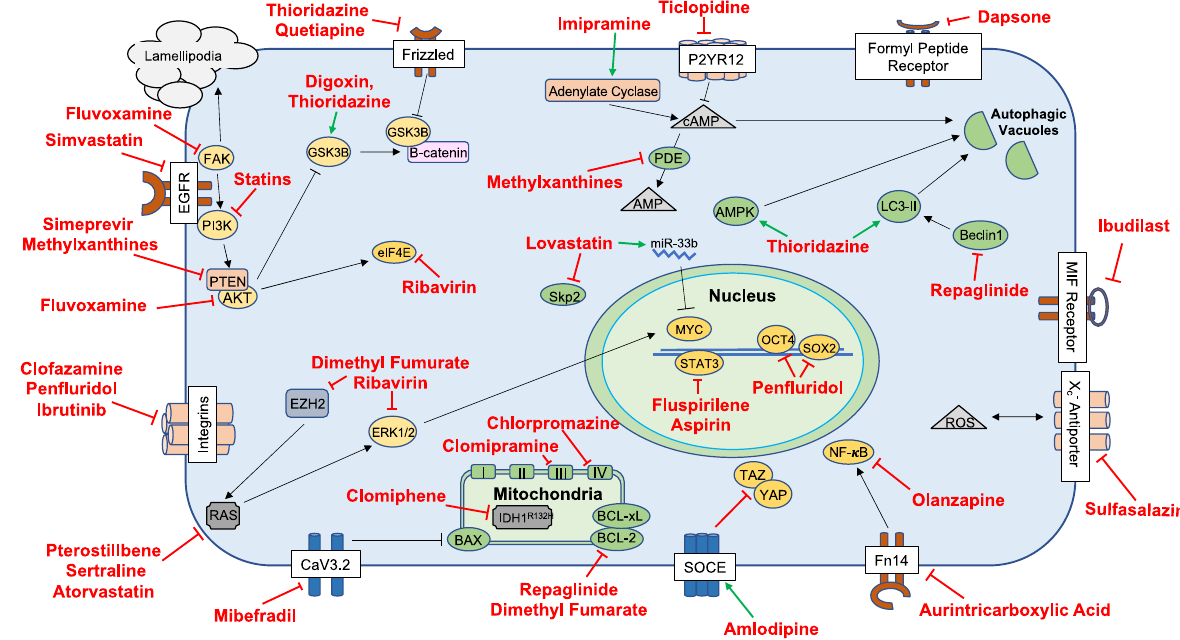
Figure 1. Cellular pathways and interactions detailing the key proposed mechanisms of drugs that have completed preclinical investigation and have yet to be fully studied in the clinical setting. Abbreviations: Adenosine diphosphate receptor (P2YR12); cyclic adenosine 3 (cid:48) ,5 (cid:48) -cyclic monophosphate (cAMP); adenosine 3 (cid:48) ,5 (cid:48) -cyclic monophosphate (AMP); phosphodiesterase (PDE); glycogen synthase kinase (GSK3B); phosphoinositide 3-kinase (PI3K); AMP-activated protein kinase (AMPK); microtubule-associated protein 1A/1B-light chain 3 phosphatidylethanolamine conjugate (LC3-II);